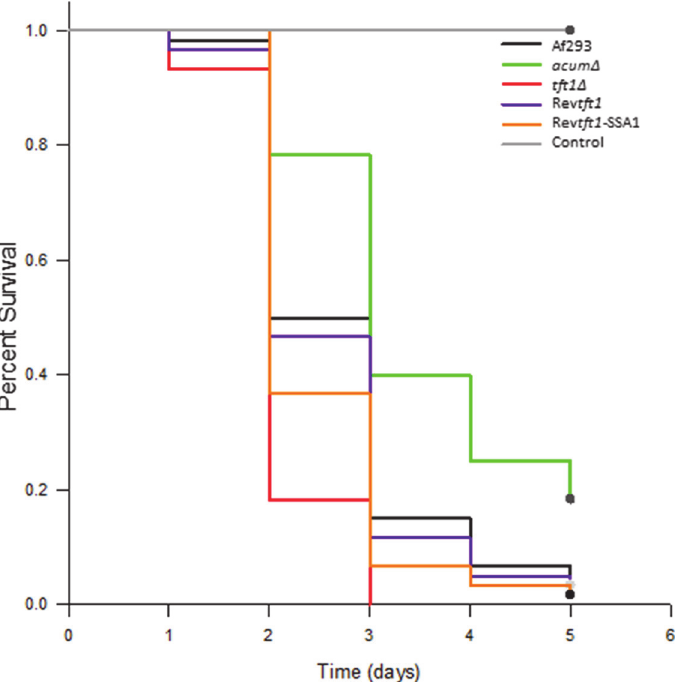
Fig 4. Log rank survival analysis of each strain after 1 x 10 6 spore injection into Galleria mellonella . tft1 Δ was shown to have a slight, yet significant (p value: .000187), increase in virulence when compared to its parent Af293. This hyper-virulence was lost upon re-introduction of the gene, either under native or strong promoter (Revtft1 and